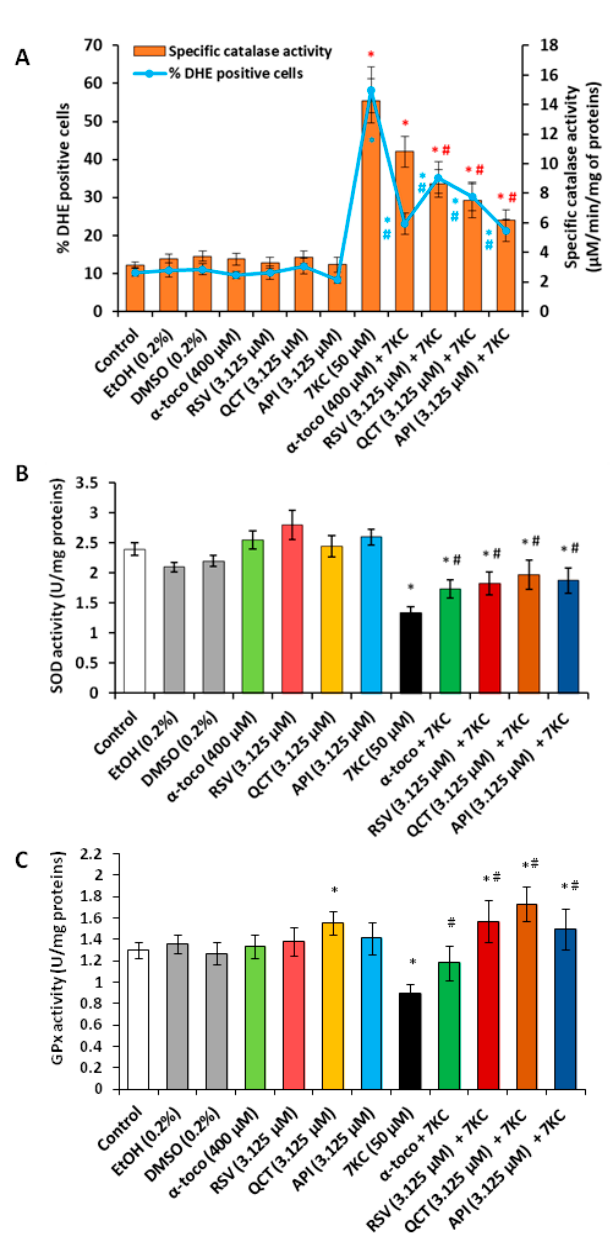
Figure 3. Effect of resveratrol, quercetin, apigenin and α -tocopherol on 7-ketocholesterol-induced oxidative stress: ROS overproduction and catalase activity, measurement of superoxide dismutase and glutathione peroxidase activity. N2a cells were cultured for 48 h with or without 7-ketocholesterol (7KC, 50 µM) in the presence or absence of α -tocopherol ( α -toco: 400 µM) used as a positive control for cytoprotection, or with polyphenols: resveratrol (RSV), quercetin (QCT) or apigenin (API) used at a concentration of 3.125 and/or 6.25 µM. ( A ) ROS overproduction was measured by flow cytometry after staining with dihydroethidine (DHE) and evaluated by the percentage of DHE positive cells. The effect on catalase activity, a peroxisomal antioxidant enzyme, which degrades hydrogen peroxide (H 2 O 2 ), was determined by a colorimetric assay with the measurement of H 2 O 2 consumption. The enzymatic activities of superoxide dismutase (SOD) ( B ) and glutathione peroxidase (GPx) ( C ) were determined by colorimetric assays. Data shown are mean ± standard deviation (SD) of three independent experiments conducted in triplicate. Significance of the differences between control (untreated cells) and RSV-, QCT-, API-, α -toco- or 7KC-treated cells; Mann–Whitney test: * p < 0.05 or less. Significance of the differences between 7KC-treated cells and (7KC + (RSV, QCT, API or α -toco)- treated cells; Mann–Whitney test: # p < 0.05 or less. No significant differences were found between control and vehicle-treated cells (Ethanol (EtOH): 0.2% and DMSO: 0.2%).